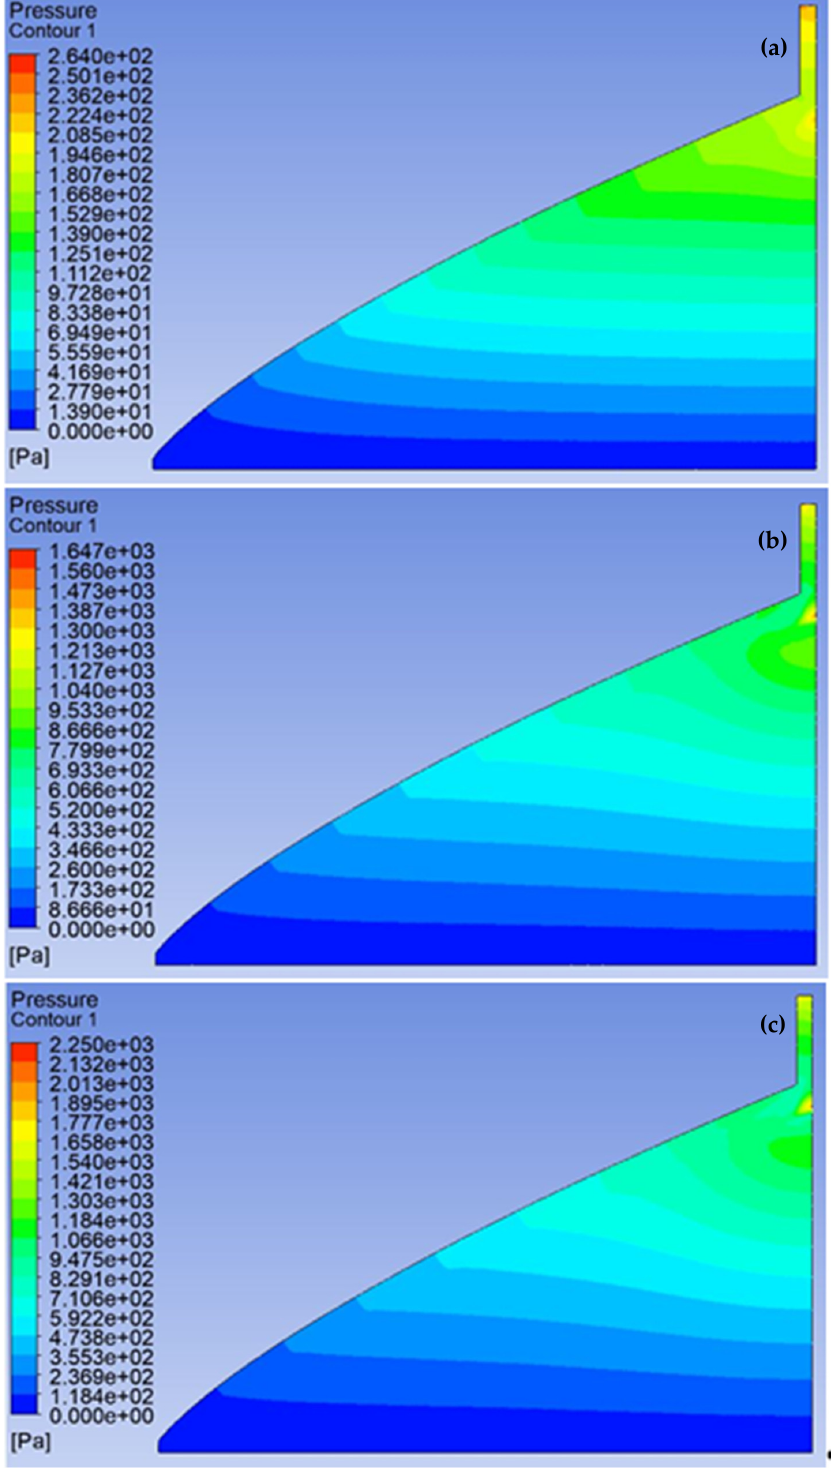
. m 1 = 0.011488 kg/s,